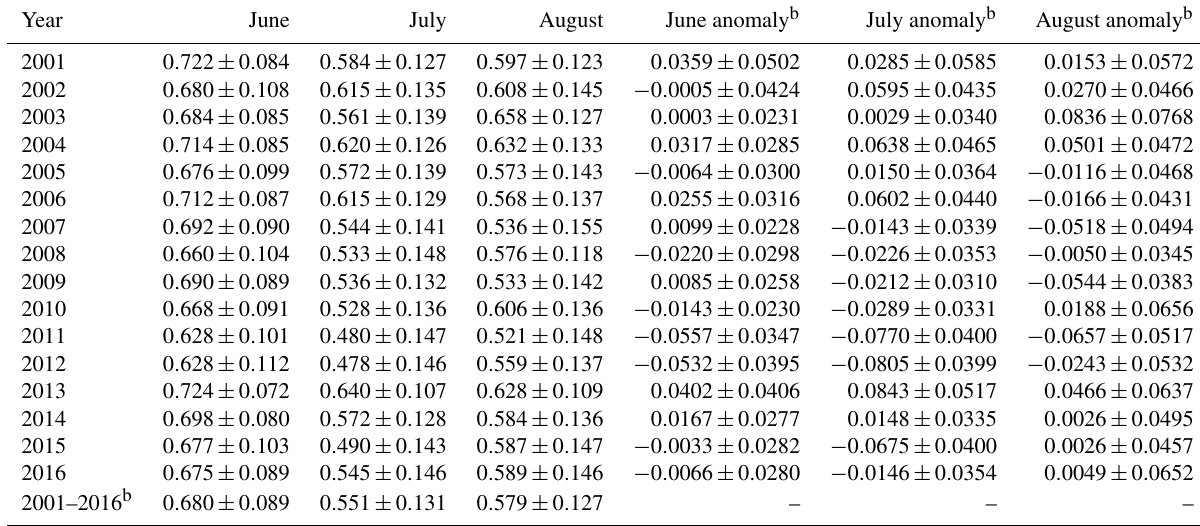
a Average of all pixels in each region having at least 11 (10 for June) of a possible 31 (30 for June) observations (see Sect. 2.3). b Pixels having June BSA observations in at least 11 of a possible 16 years (see Sect.